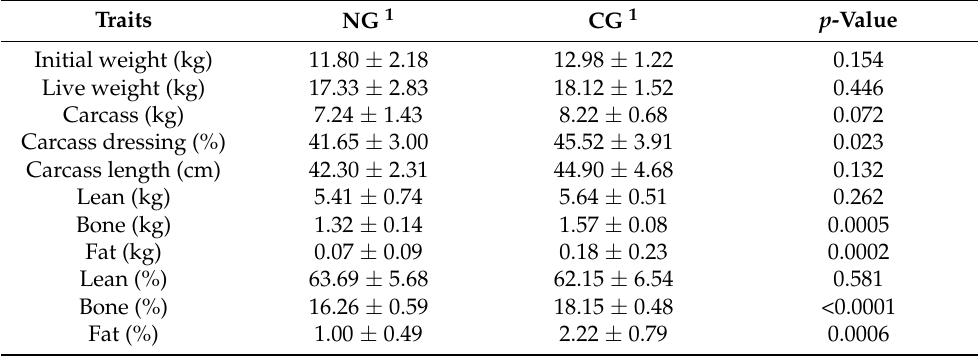
Table 1. Live weight, carcass weight, carcass percentage, carcass length, and carcass composition of Southern Thai native goats (NG) and Three-way crossbred goats (CG). Traits